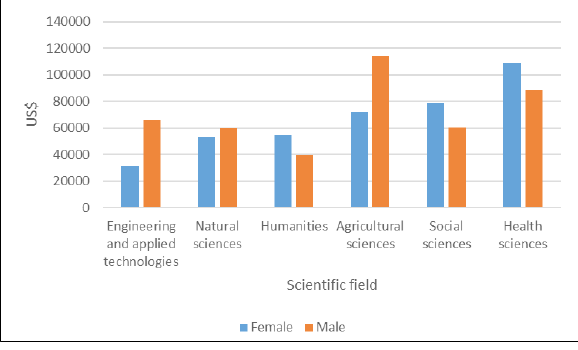
Reported amount of funding received, by gender and